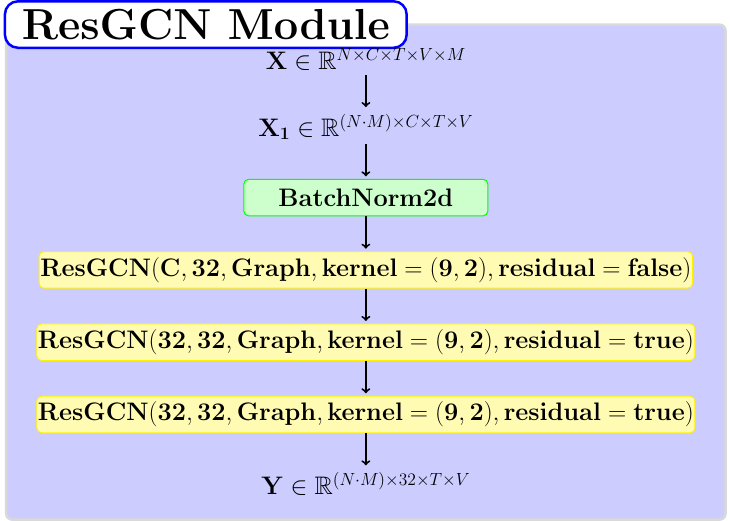
Figure 3. The structure of the ResGCN layer-based module.